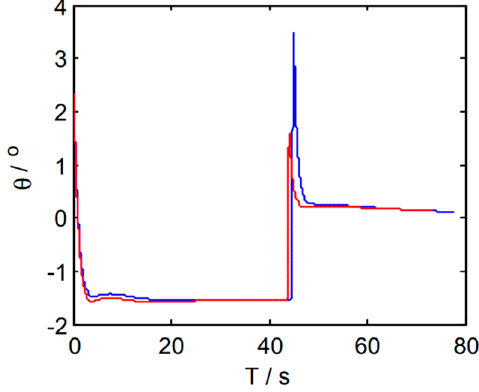
Figure 17. Pitch angle in headwind conditions.